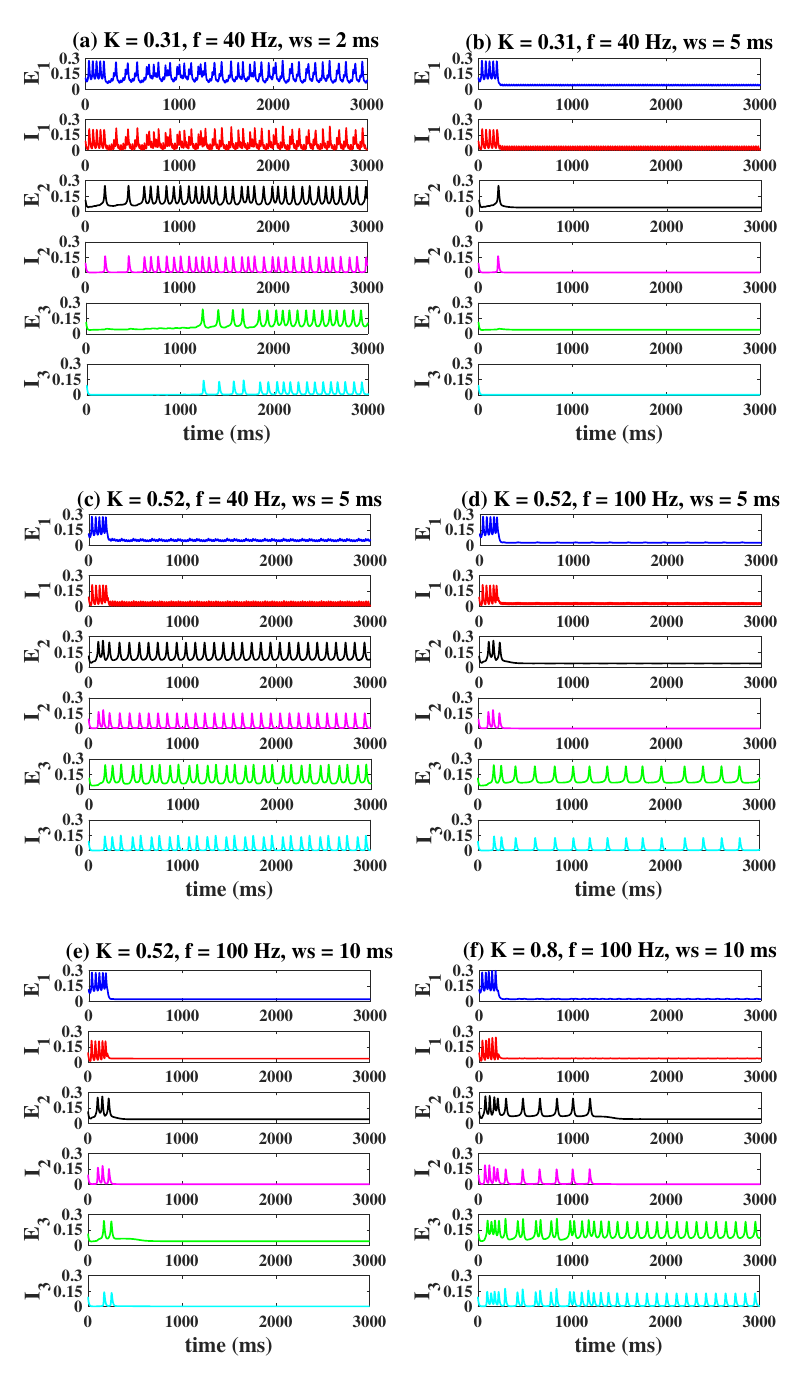
Figure 10. Under the different coupling strengths K , time series of the three columns when OS targets I 1 with different stimulus parameters. When K is small ( K = 0.31, K = 0.52), the proper OS can always control all the three columns ( b , e ). However, if the value of K is larger ( K = 0.8), column3 cannot always be controlled regardless of the settings of the stimulus parameters ( f